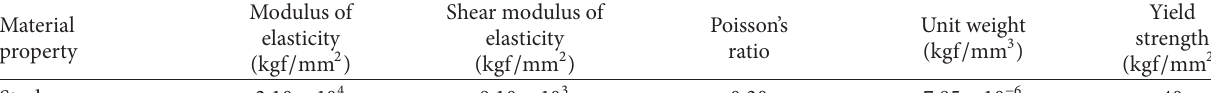
Table 2: Material properties of the cable-stayed bridge model.